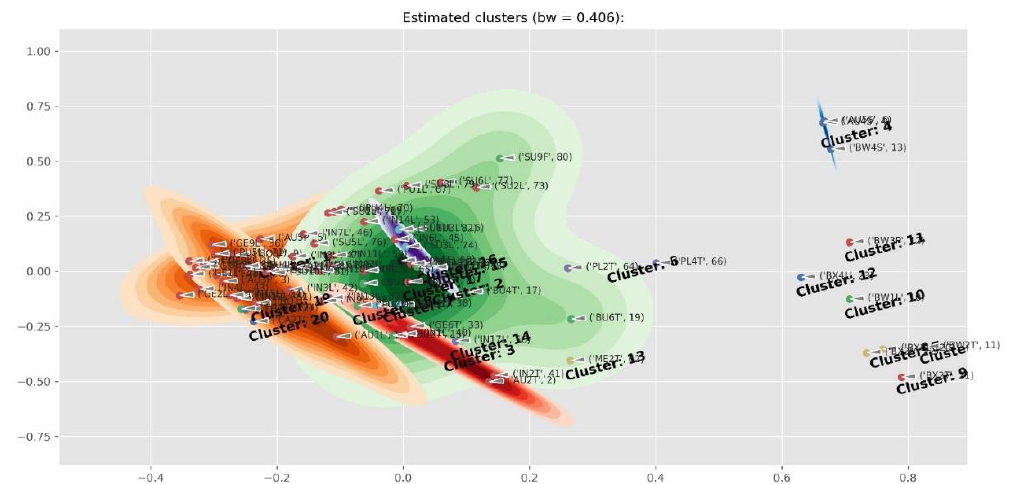
Figure 5. Cluster map showing the two Cyclopia species that apparently do not produce mangiferin ( C. buxifolia , BX and C. bowieana , BW) as outliers on the right hand side. C. aurescens (AU), C. bolusii (BO), C. bowiena (BW), C. burtonii (BU), C. buxifolia (BX), C. capensis (CA), C. falcata (FA), C. genistoides (GE), C. glabra (GL), C. intermedia (IN), C. maculata (MA), C. meyeriana (ME), C. plicata (PL), C. pubescens (PU) and C. subternata (SU).